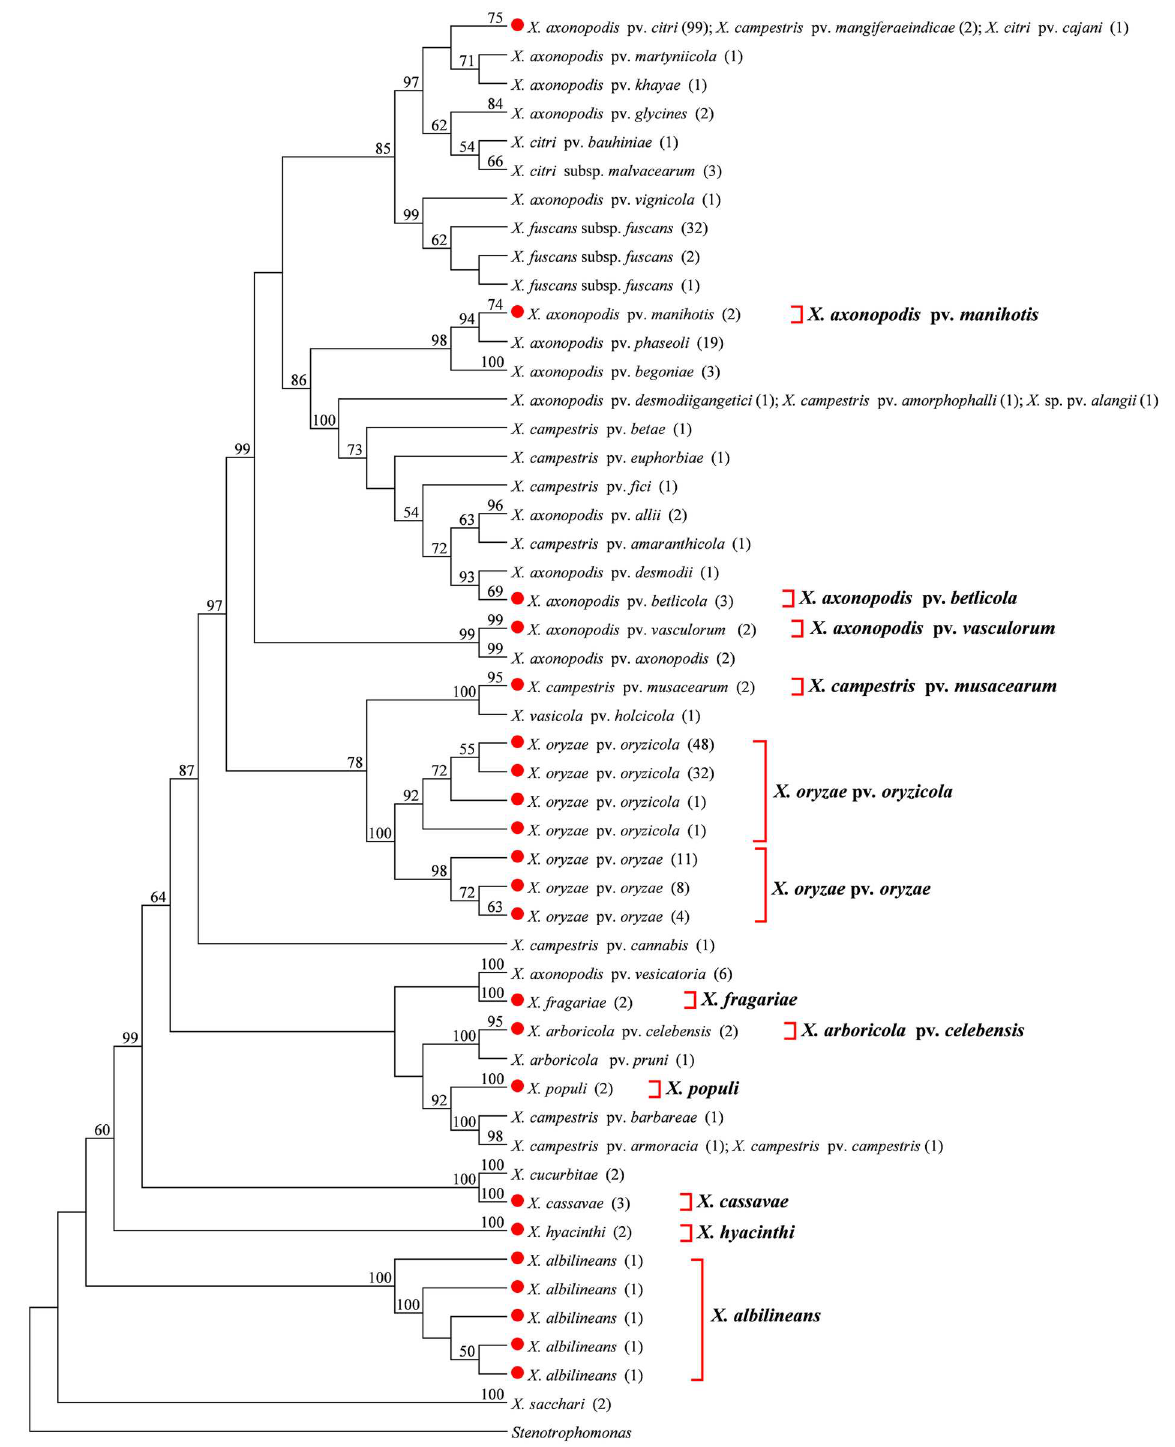
Fig 2. Neighbor-joining tree based on gyrB . Bootstrap values ( > 50%)are shown abovethe branches. Identicalsequencesare represented only once. Numbers followingtaxon names indicatethe number of isolates. Red dots indicate quarantine Xanthomonas species/pathovars. Species/pathovars that were successfully identified are shown on the right.